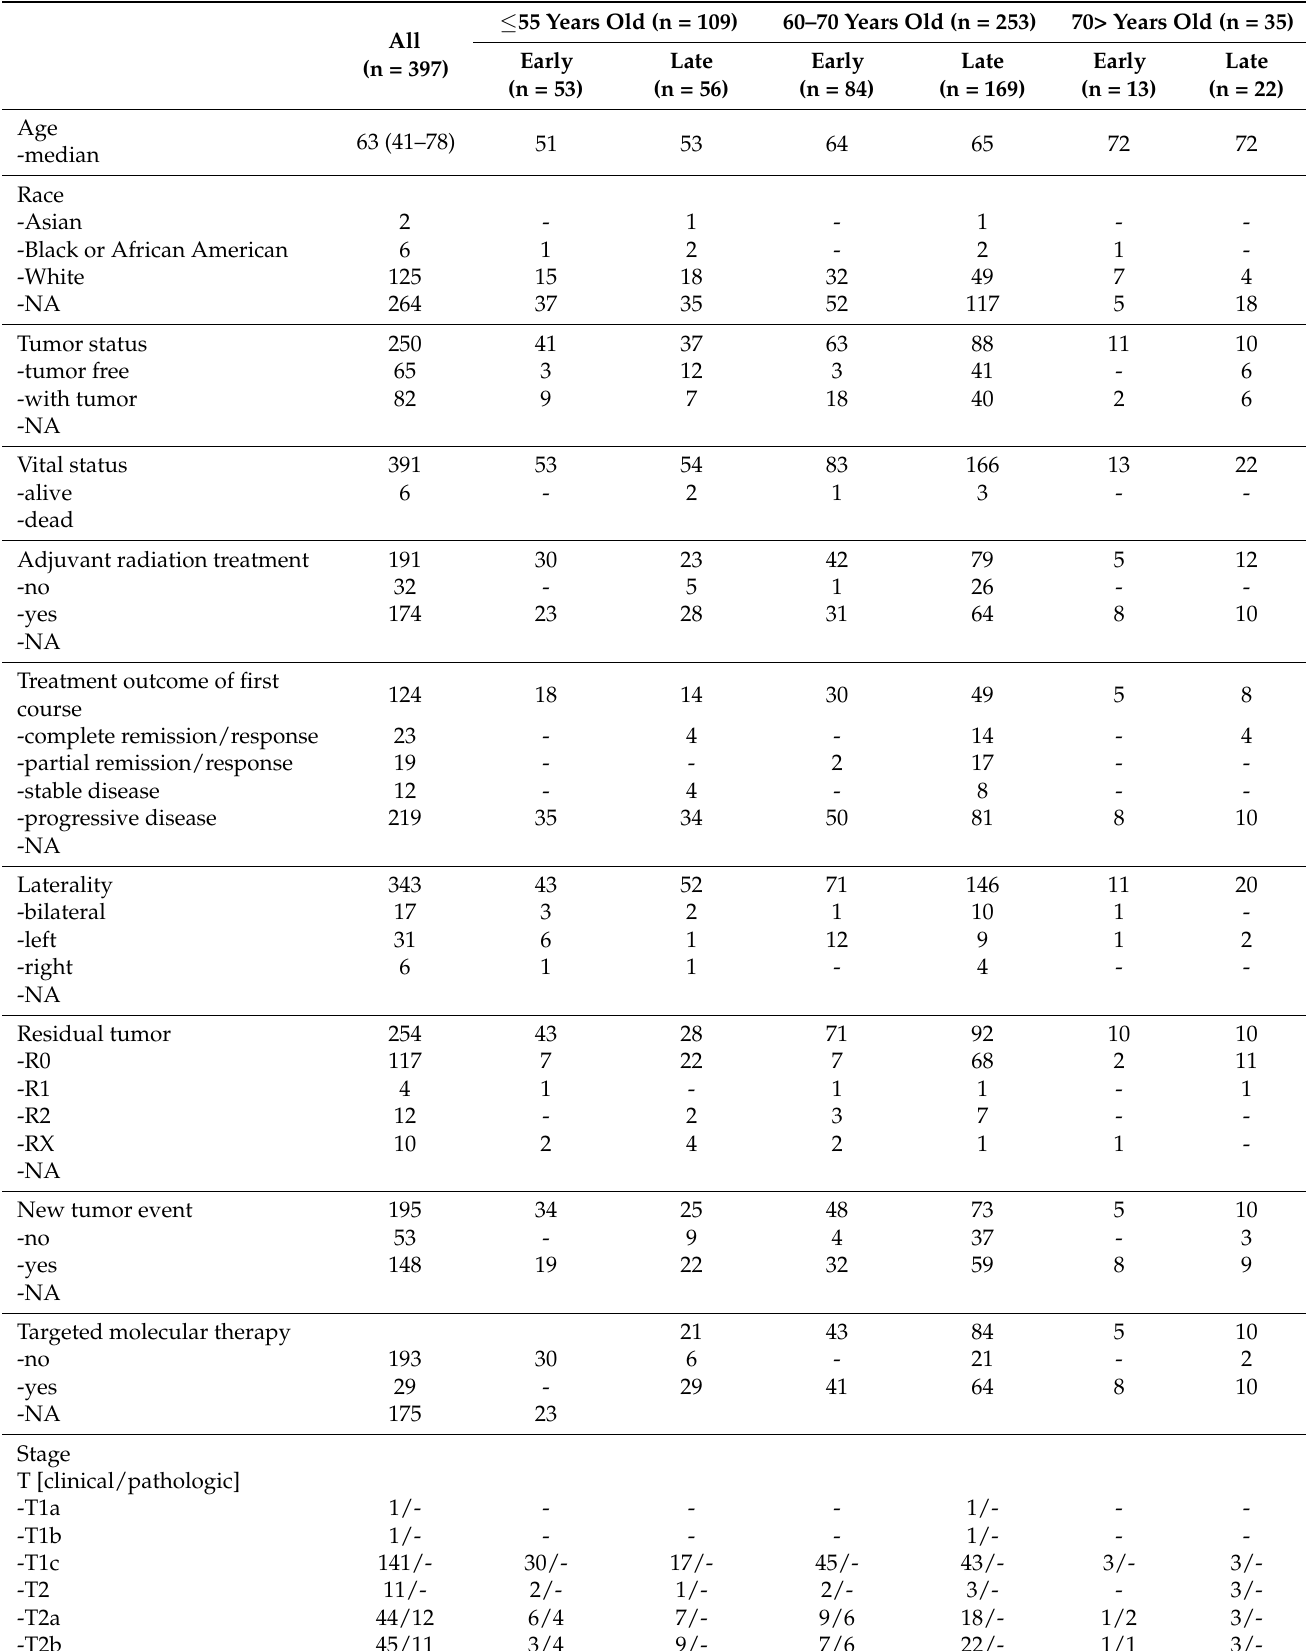
Table 7. Detailed characteristics of the studied